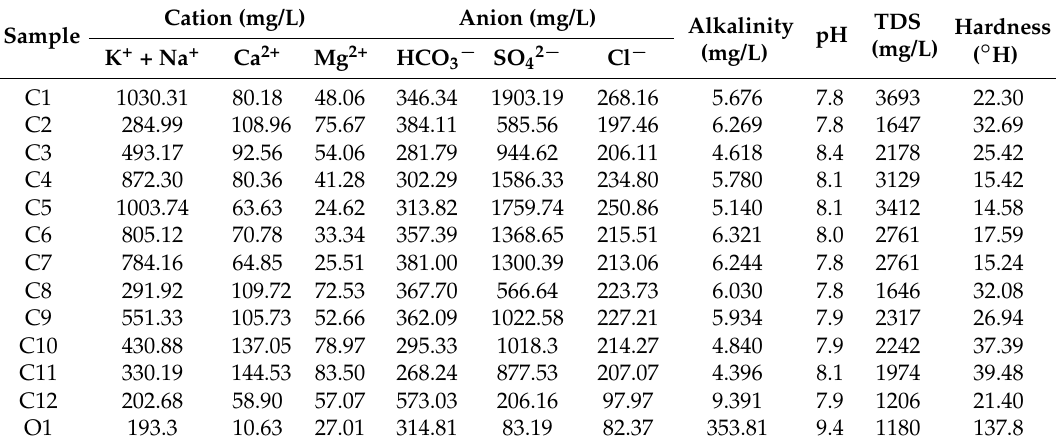
Table 2. Chemical properties of each groundwater sample.